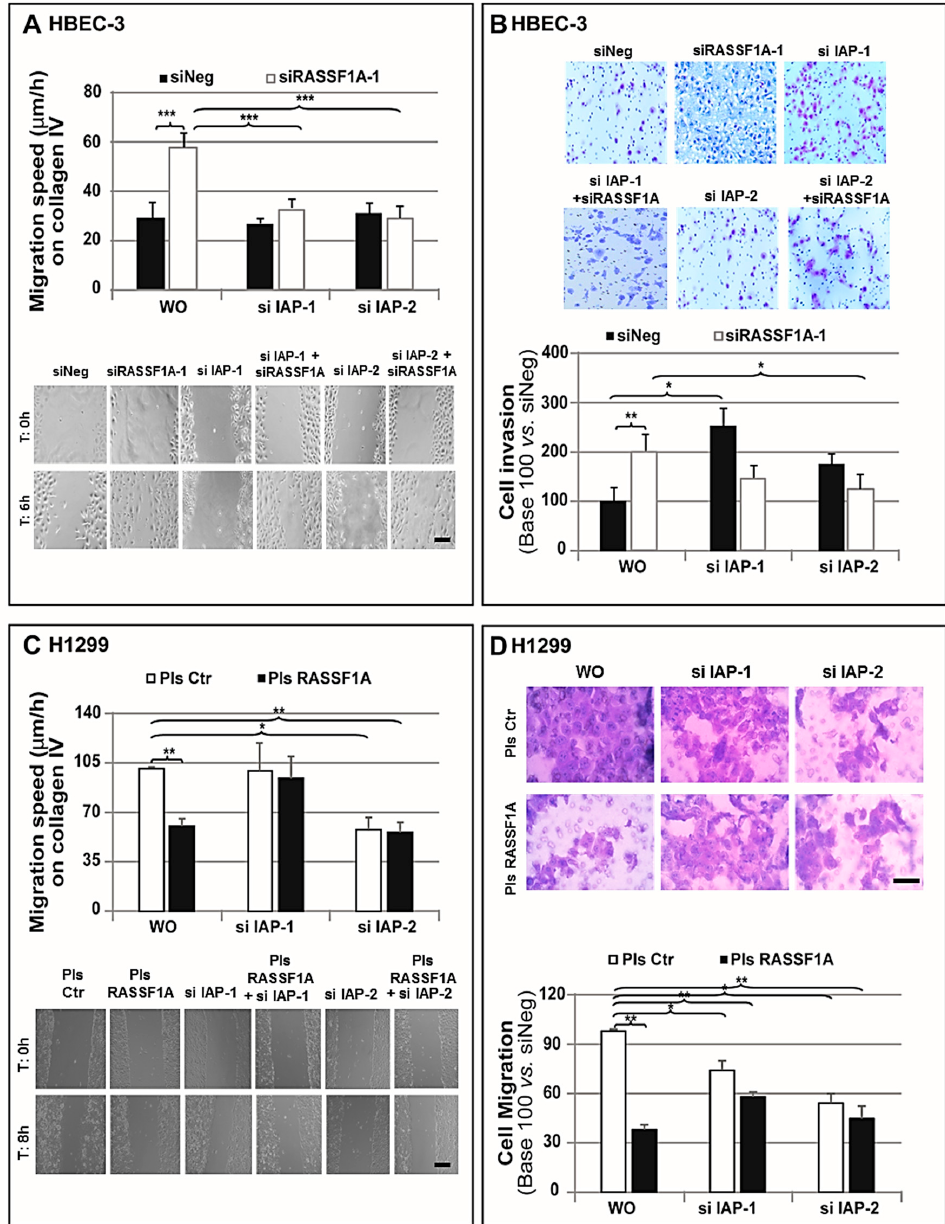
Figure 5. The increase of IAP-2 expression is critical for RASSF1A-mediated effects on cell migration and invasion. HBEC-3 cells were transiently transfected with siNeg and siRASSF1A-1, whereas A549 and H1299 cells were transfected with plasmid coding wild-type RASSF1A both in and without combination with siRNA targeting IAP-1 and IAP-2, (as indicated on x-axis). ( A,C ) Migration speed (µm/h) was assessed by the wound-healing assay in ( A ) HBEC-3 (scale bar, 100 µm) and ( C ) H1299 cells (Scale bar, 200 µm). ( B ) Invasion capacity of transfected HBEC-3 cells was measured using Matrigel ® -coated Invasion Transwell. Relative invasion normalized to that of the cells transfected with siNeg. Scale bar: 50 µm. ( D ) 3D Migration capacity was measured using Transwell without any coating. Relative invasion normalized to that of the cells transfected with control mimic plasmid. Scale bar: 50 µm. The data were expressed as the mean ± SEM from three individual experiments. The statistical significance was determined using a Student’s t -test. * p < 0.05; ** p < 0.01; *** p < 0.001.